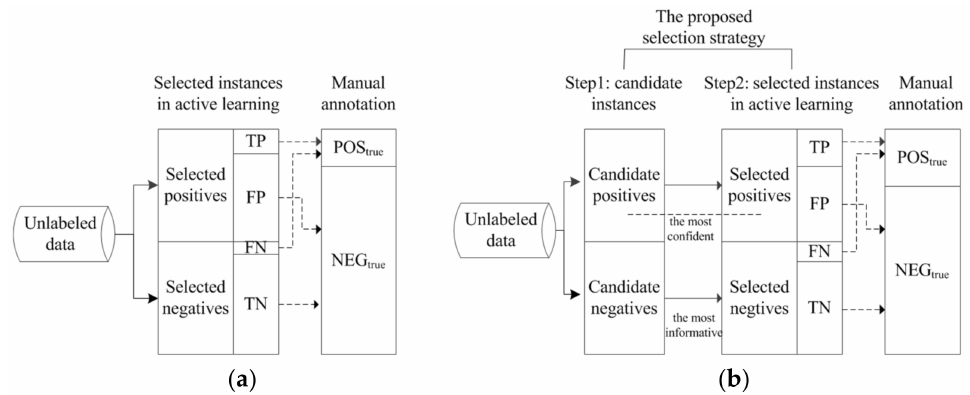
Figure 2. Motivation of the proposed selection strategy. ( a ) Active learning without our proposed selection strategy; ( b ) active learning using our proposed selection